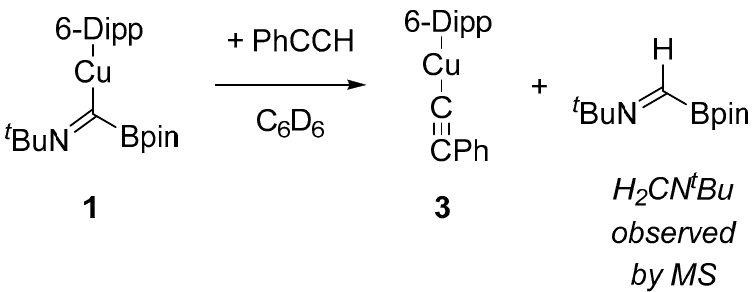
Figure 3. Molecular structure (30% probability ellipsoids) of 3 . Hydrogen atoms and the second disordered component have been omitted for visual clarity. Wireframe view has been employed for Dipp groups, also for visual simplicity. Selected bond lengths (Å), angles (°): N1-C1 1.339(3); N2-C1